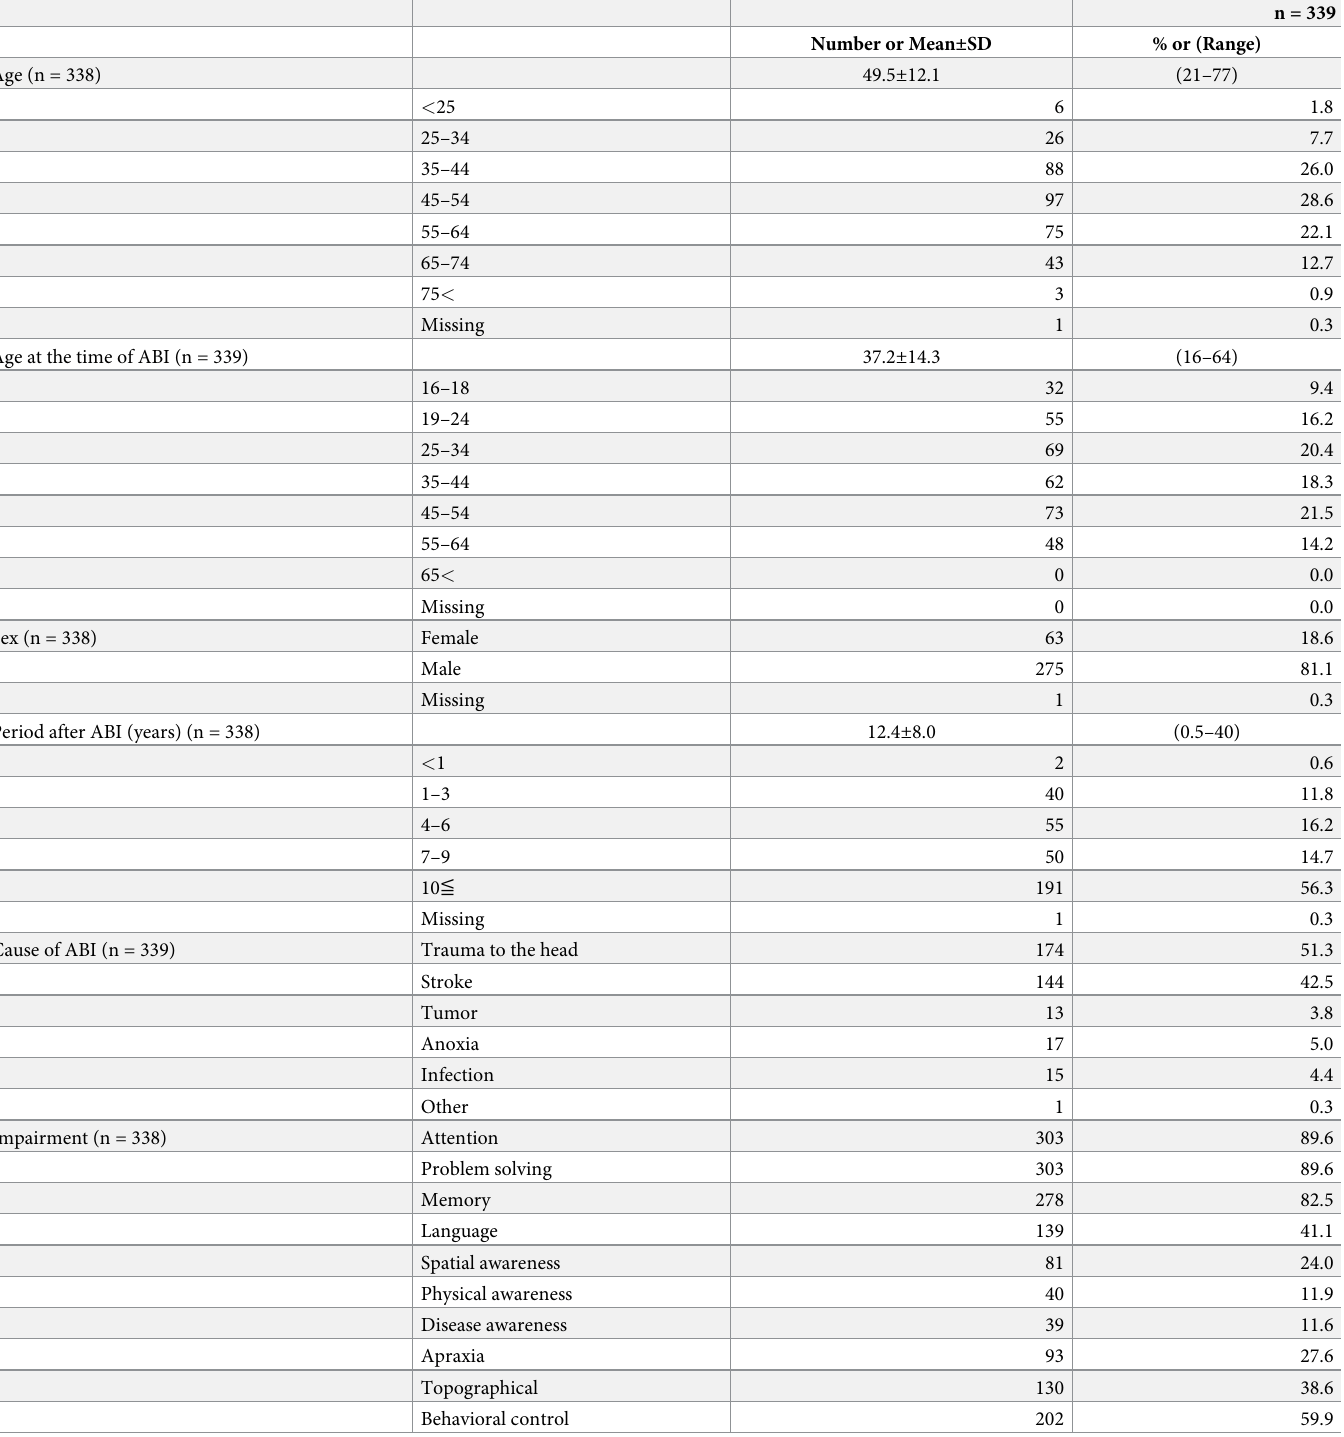
Table 2. Demographic characteristics of individuals with